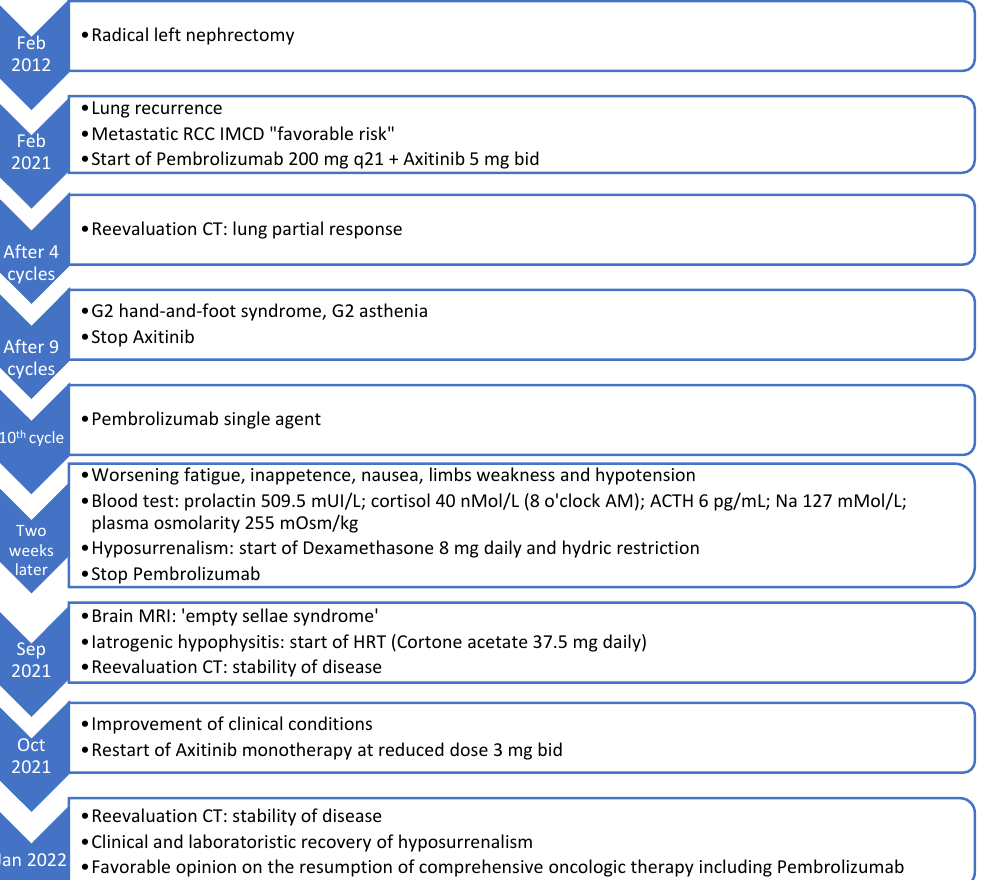
Figure 2. Partial “empty sellae syndrome” on brain MRI coronal section.